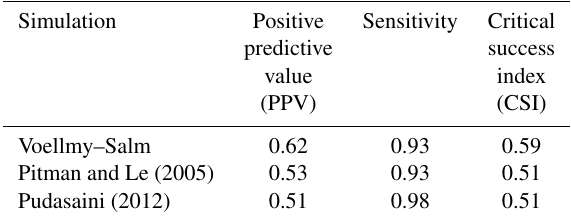
Table 2. Pixel-pair performance assessment results for all flow sim- ulations at a depth cut-off of 0.5m. Simulation Positive Sensitivity Critical predictive success value index (PPV) (CSI) Voellmy–Salm 0.62